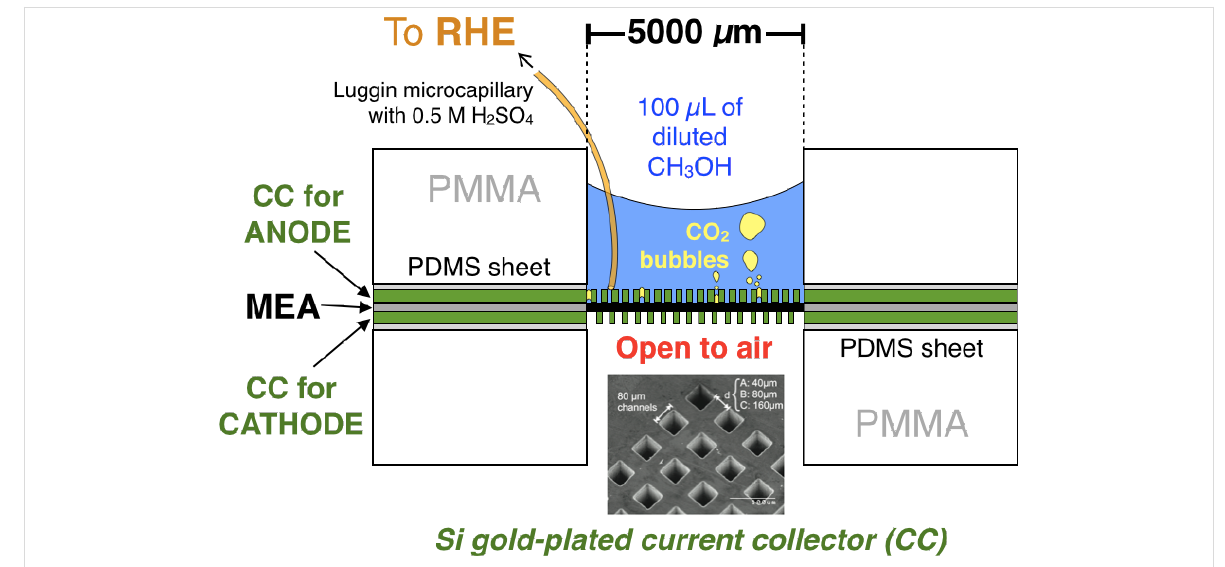
Figure 5: Scheme of the passive µDMFC with Luggin